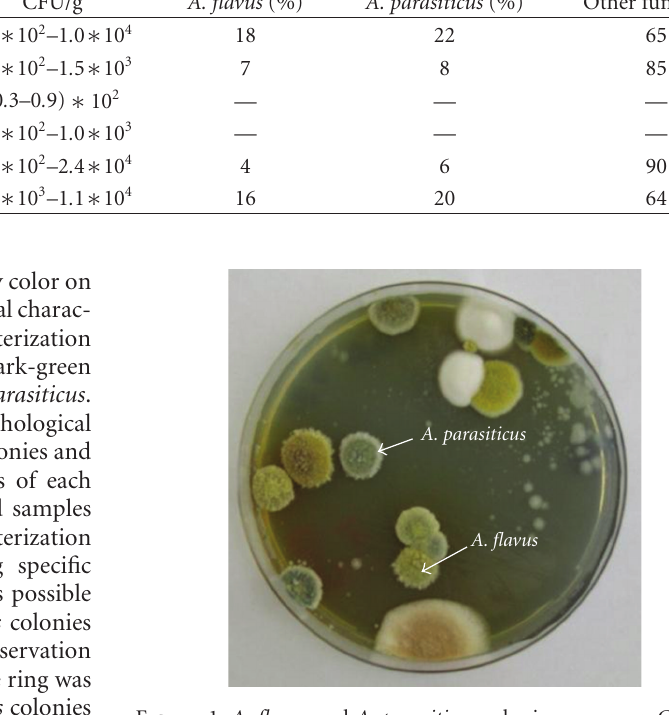
Table 2: Fungi detected in contaminated food and feed samples analyzed during January 2010 to November 2011. Types of samples